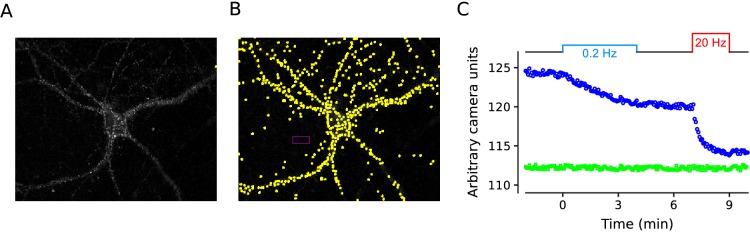
Example experiment.Example of FM4-64 experiments quantified in Figure 7. (A) Difference image generated by subtracting the mean of 10 images after destaining from the mean of the 30 baseline images after staining, but before destaining with electrical stimulation. (B) Same as in (A) with 540 regions of interest (ROIs) demarcated in yellow, and the area used to calculate the background fluorescence demarcated in magenta. Images from time-lapse experiments were aligned using the imagej plugin StackReg:Translation (Thévenaz et al., 1998) and in house software. Sampling frequency was 1 image every 4s. ROIs were 2 X 2 camera pixels, corresponding to an image area of 1 μm X 1 μm, and were detected with in house software based on the change in contrast compared to surrounding area over the full experiment. (C) Blue circles are median values of ROIs vs time for experiment in (A and B), green squares are mean values of background area.